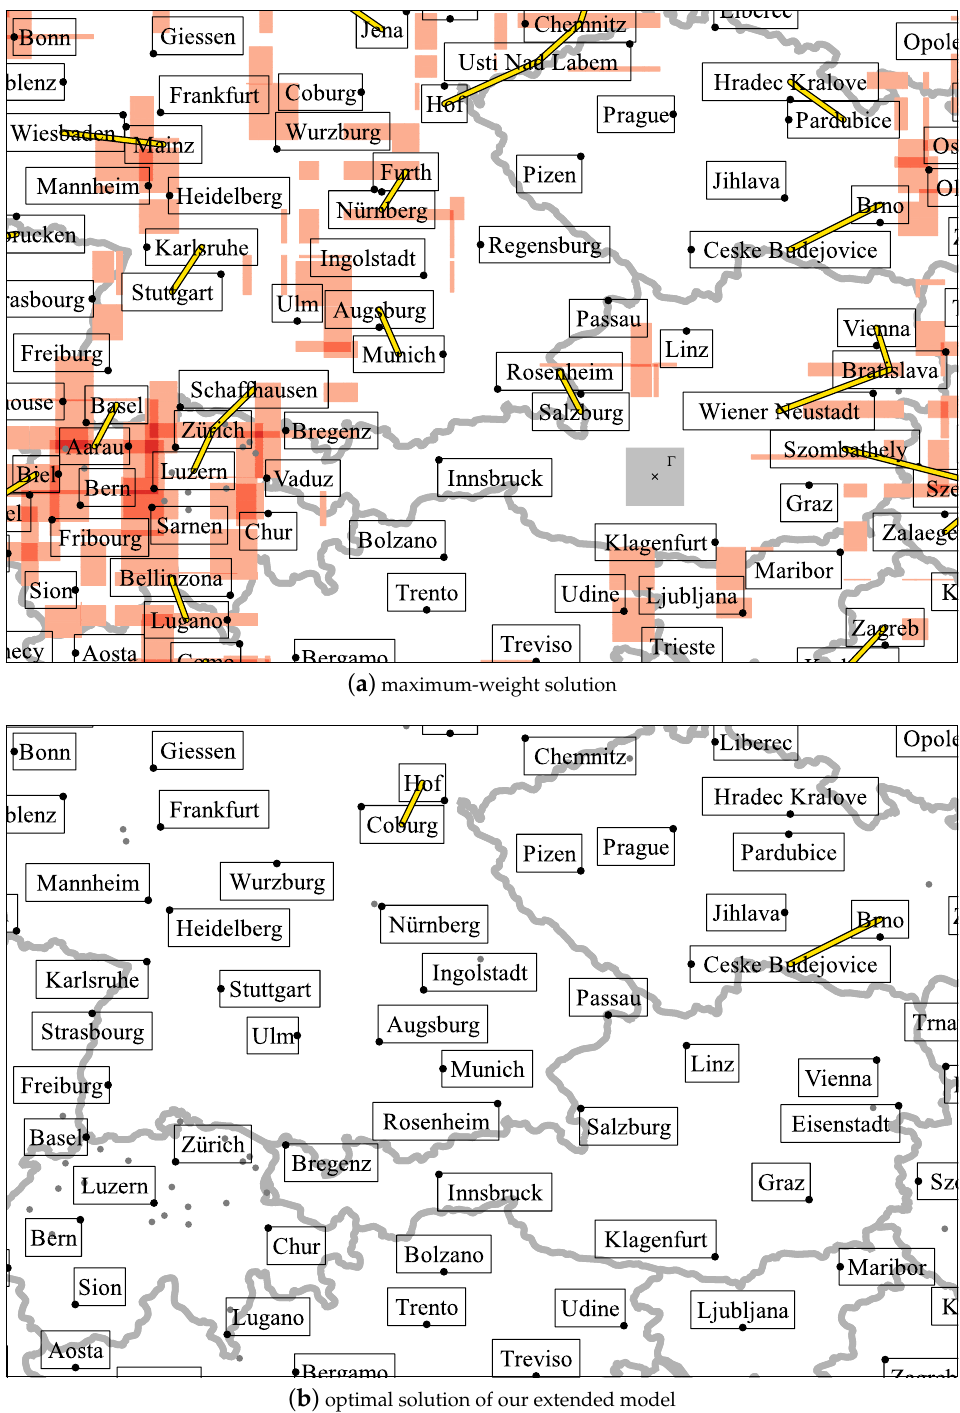
Figure 9. The two maps show the same section of two labelings for the instance in Figure 8. Yellow lines represent pairs of labels whose corresponding y -variables have been constrained to 1; only in the second labeling, costs for those variables have been charged to avoid ambiguous label–point associations. Red areas represent points where centering Γ would cause intersections with more than two labels (from light red to dark red: three, four, five intersections). Because of Constraint (8), there are no such areas in the second solution. Unlabeled points are displayed gray and will not be visible in the final map. Country borders were not considered for labeling but are displayed to provide